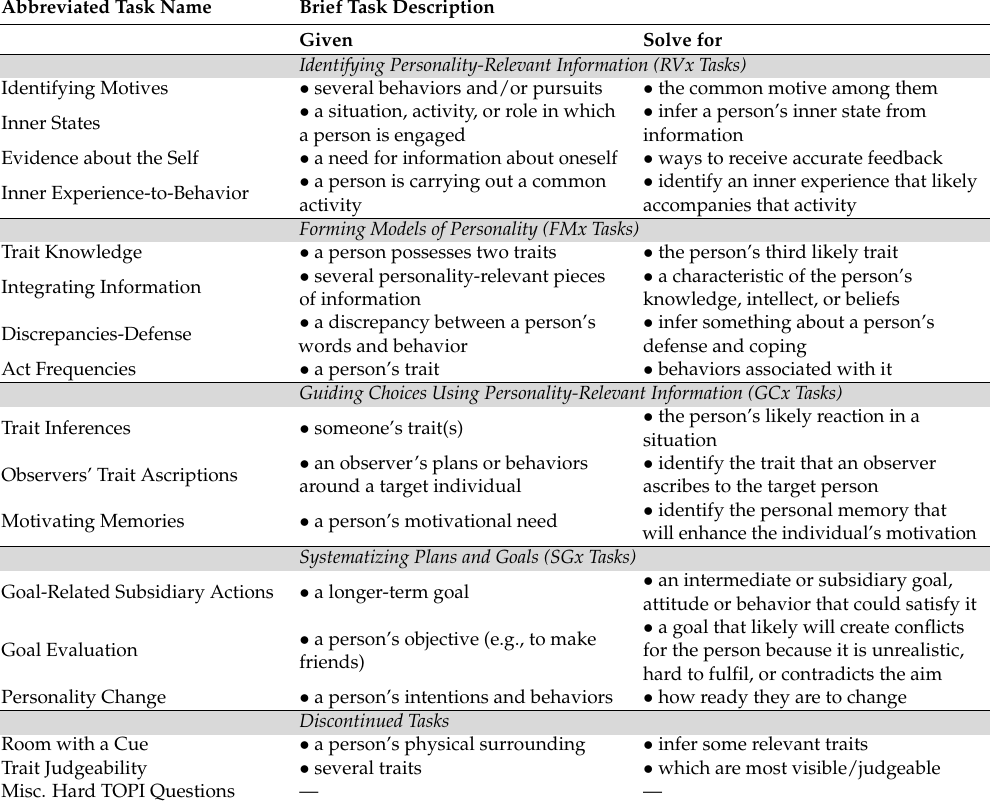
Table 1. An overview and reference guide to TOPI clusters by area in the Test of Personal Intelligence Versions 2 through